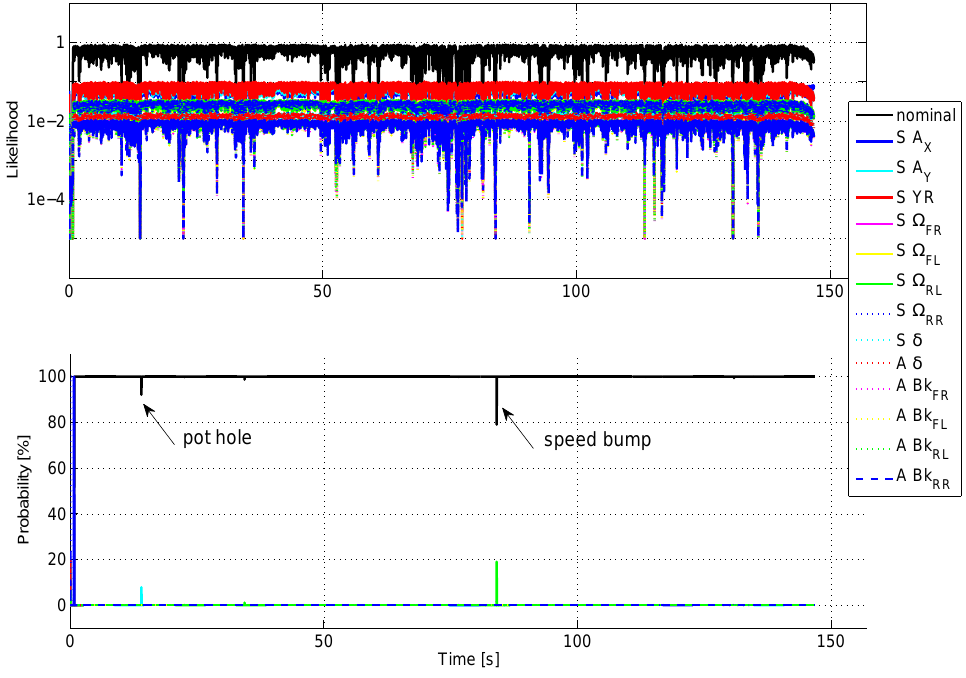
Figure 8. Robustness to false detection in urban driving.